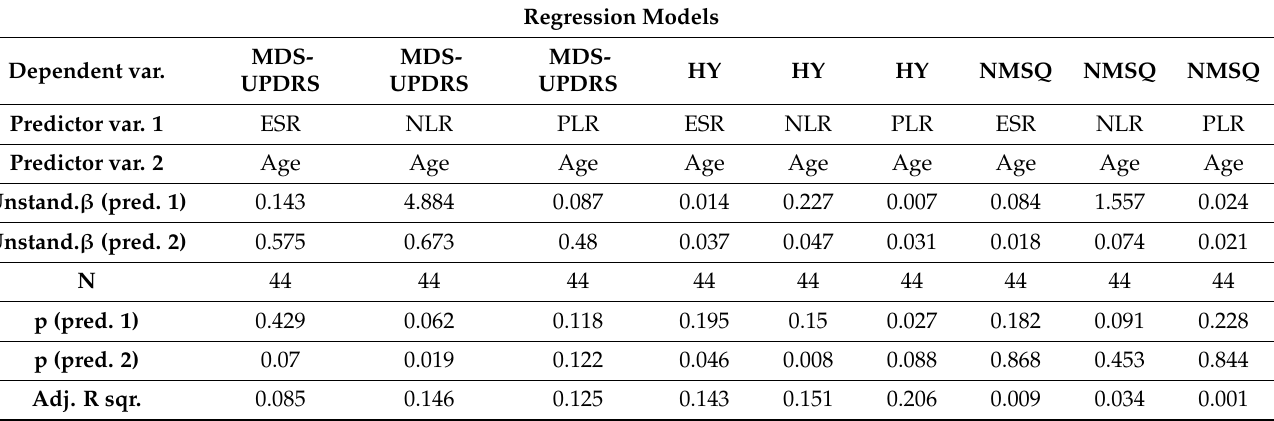
Table 3. Linear regression models utilized to assess if the different variables predicted the most important clinical parameters in PD patients; the influence of age was also considered as a